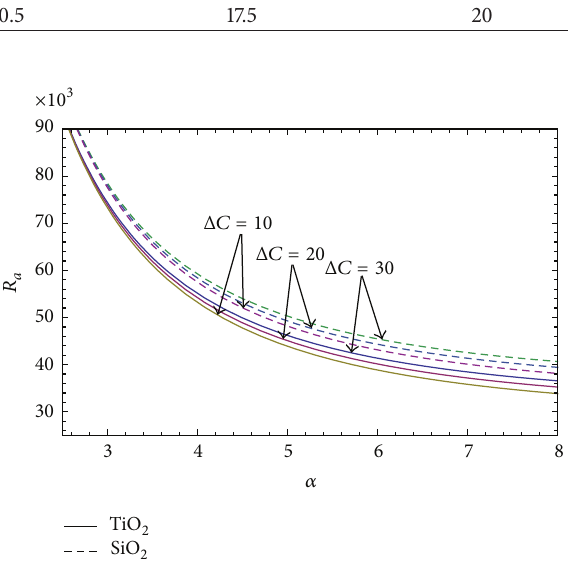
Figure 6: Effect of Δ𝐶 on semiconducting nanoparticles.